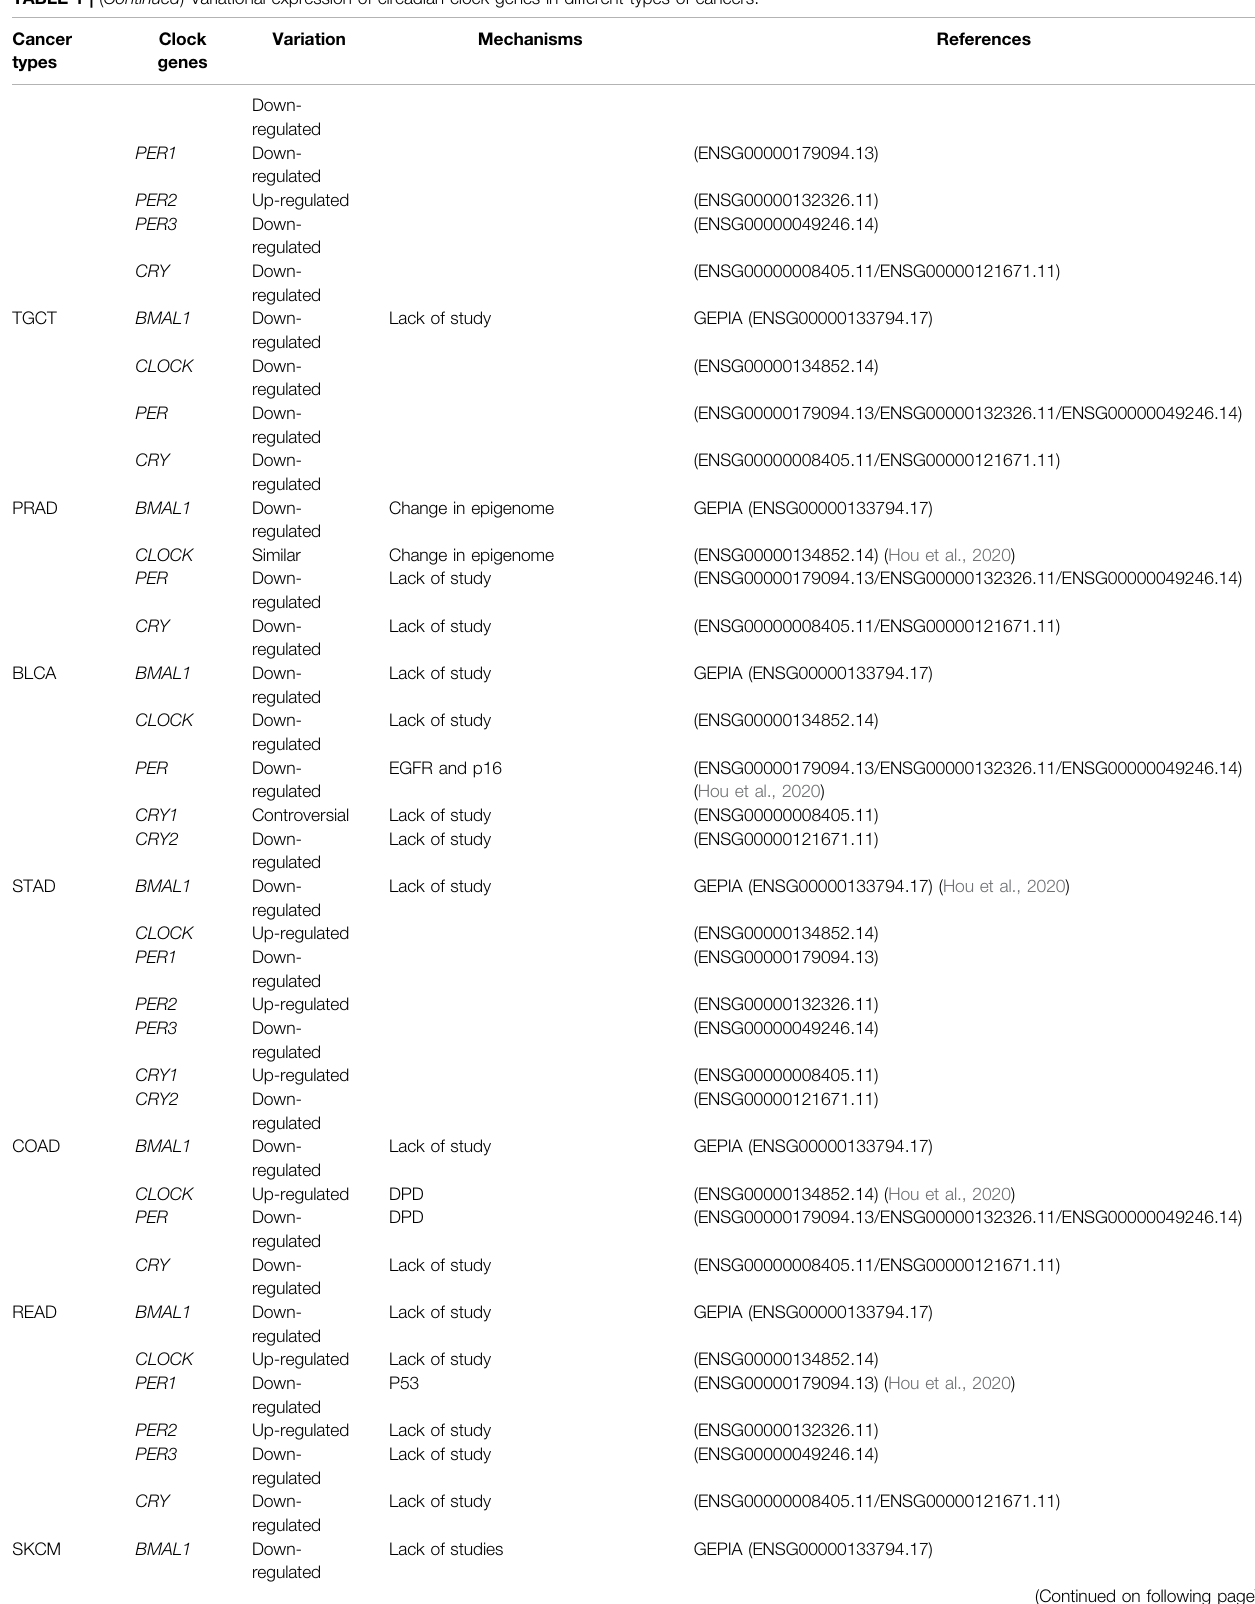
TABLE 1 | ( Continued ) Variational expression of circadian clock genes in different types of